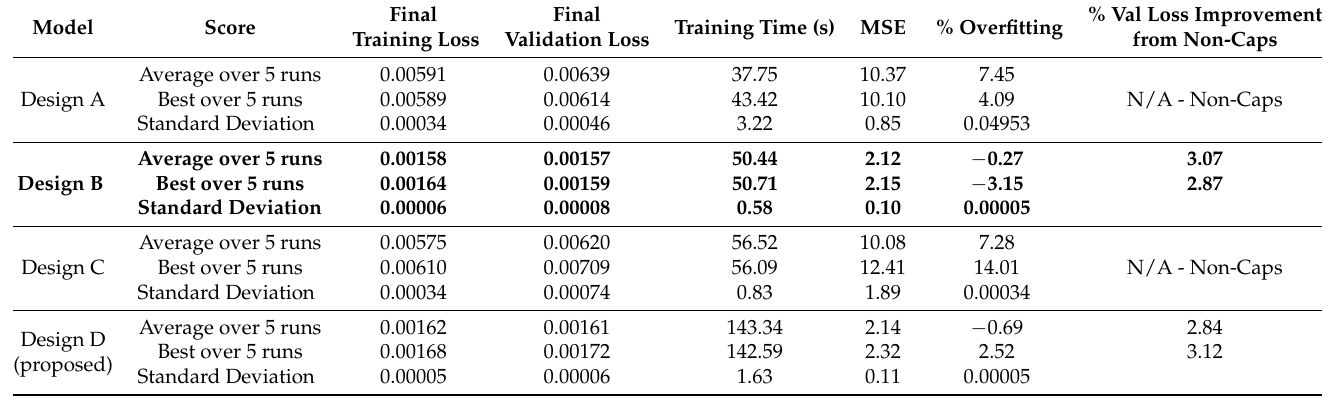
Table 4. Results for training for each NN model in Figure 5 using the hyperparameters from Table 3.